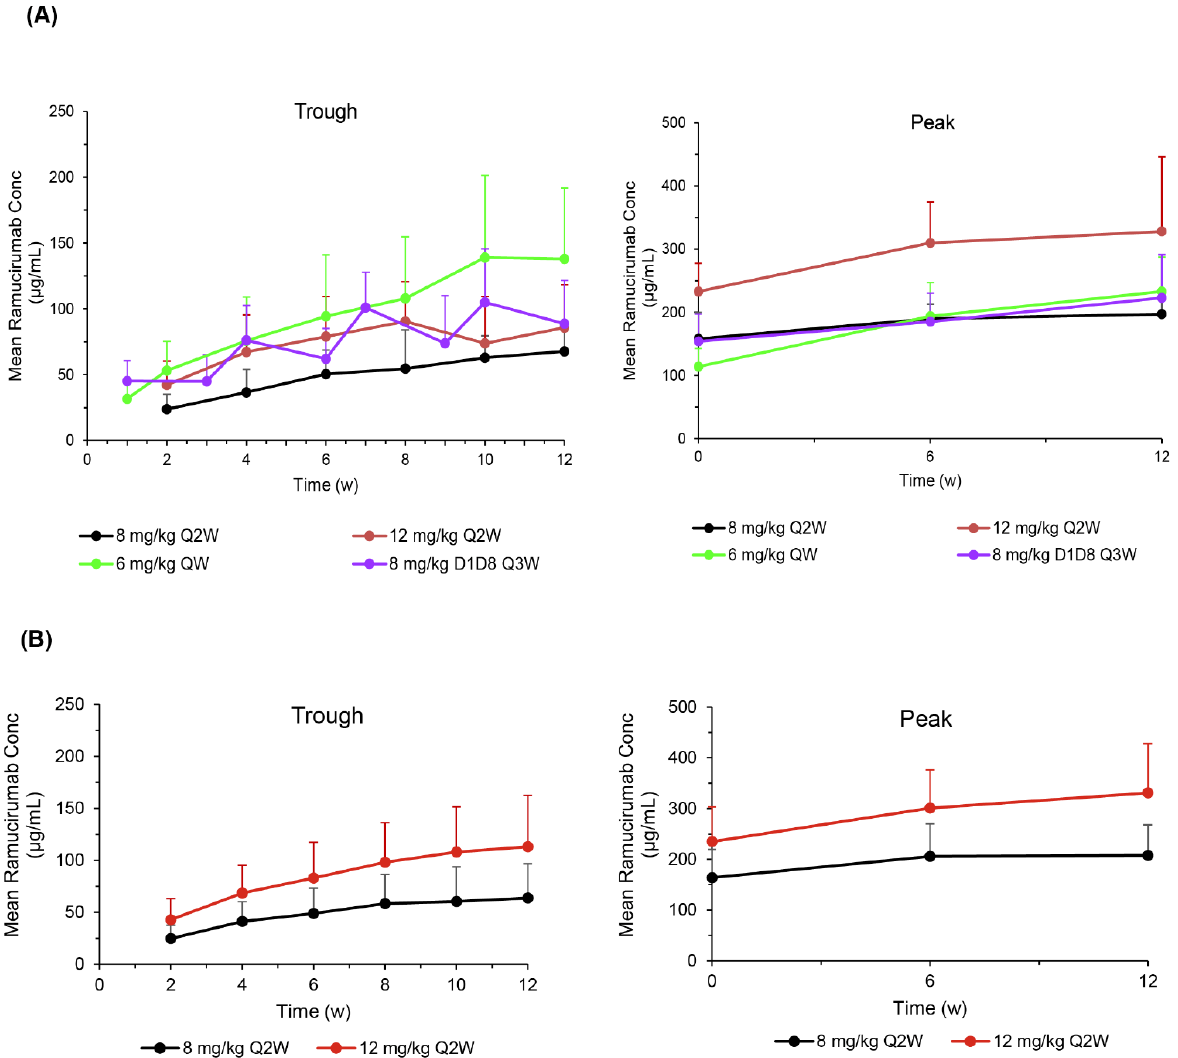
Figure 1. ( A ) JVDB ramucirumab trough and peak serum concentrations (mean ± SD) before and after administration of indicated doses of ramucirumab monotherapy ( n = 160 patients). ( B ) JVCZ ramucirumab trough and peak serum concentrations before and after administration of ramucirumab 8 or 12 mg/kg in combination with paclitaxel ( n = 232 patients). Abbreviations: Conc—concentration; D—day; Q2W—every 2 weeks; Q3W—every 3 weeks; QW—weekly; SD—standard deviation; w—weeks.